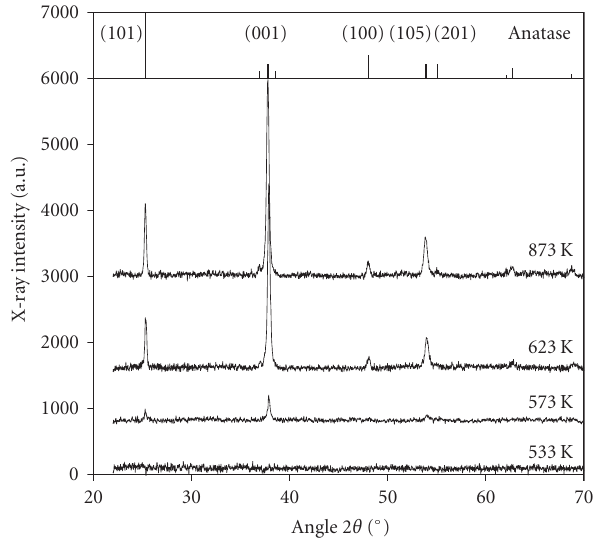
Figure 1: X-ray di ff raction spectra of TiO 2 thin films deposited on bare soda-lime glass. The films were sputter deposited at 50W, 1 . 4Pa and annealed for 1h. Included are the powder spectra of anatase (ASTM 21-1272) and rutile (21-1276).